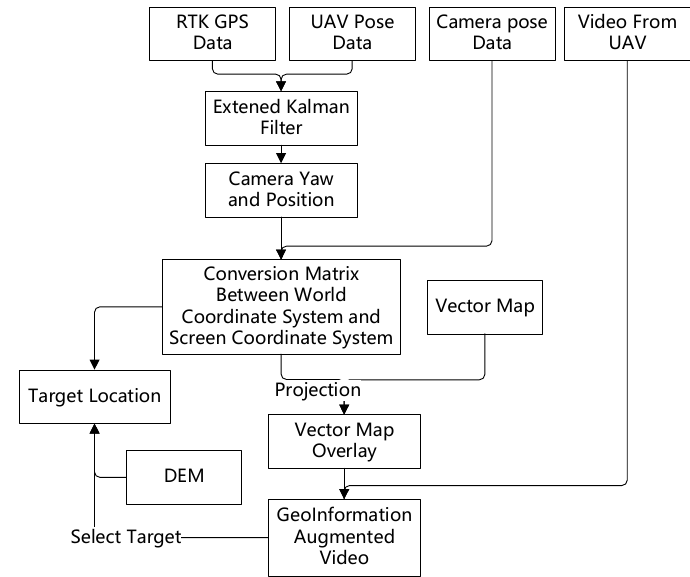
Figure 5. The full structure of the proposed method.